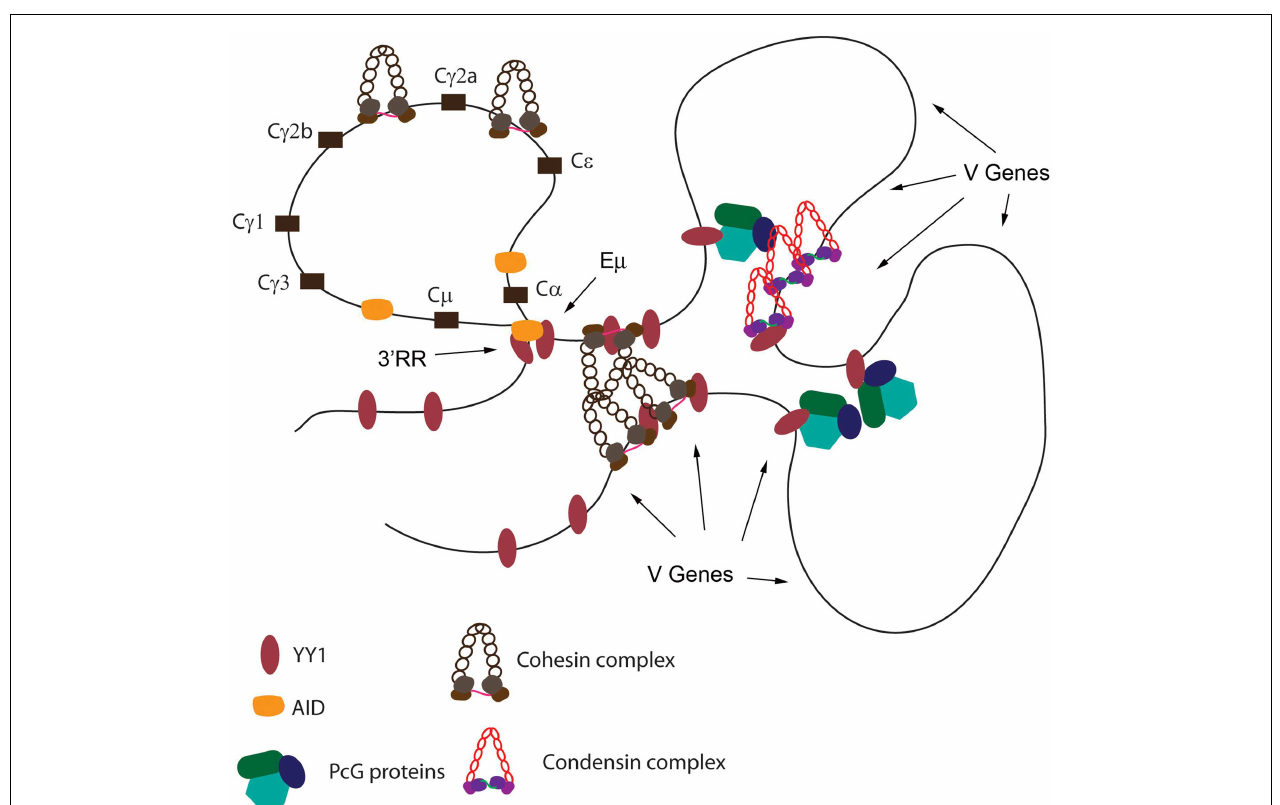
interactions. Positions of the E µ enhancer, 3 (cid:48) RR enhancer, and variousV genes are shown by arrows. Black rectangles represent various C H constant regions.YY1 also physically interacts with AID, and AID is able to interact with condensin, and cohesin complexes, and thus may contribute to DNA loop formation in germinal center B